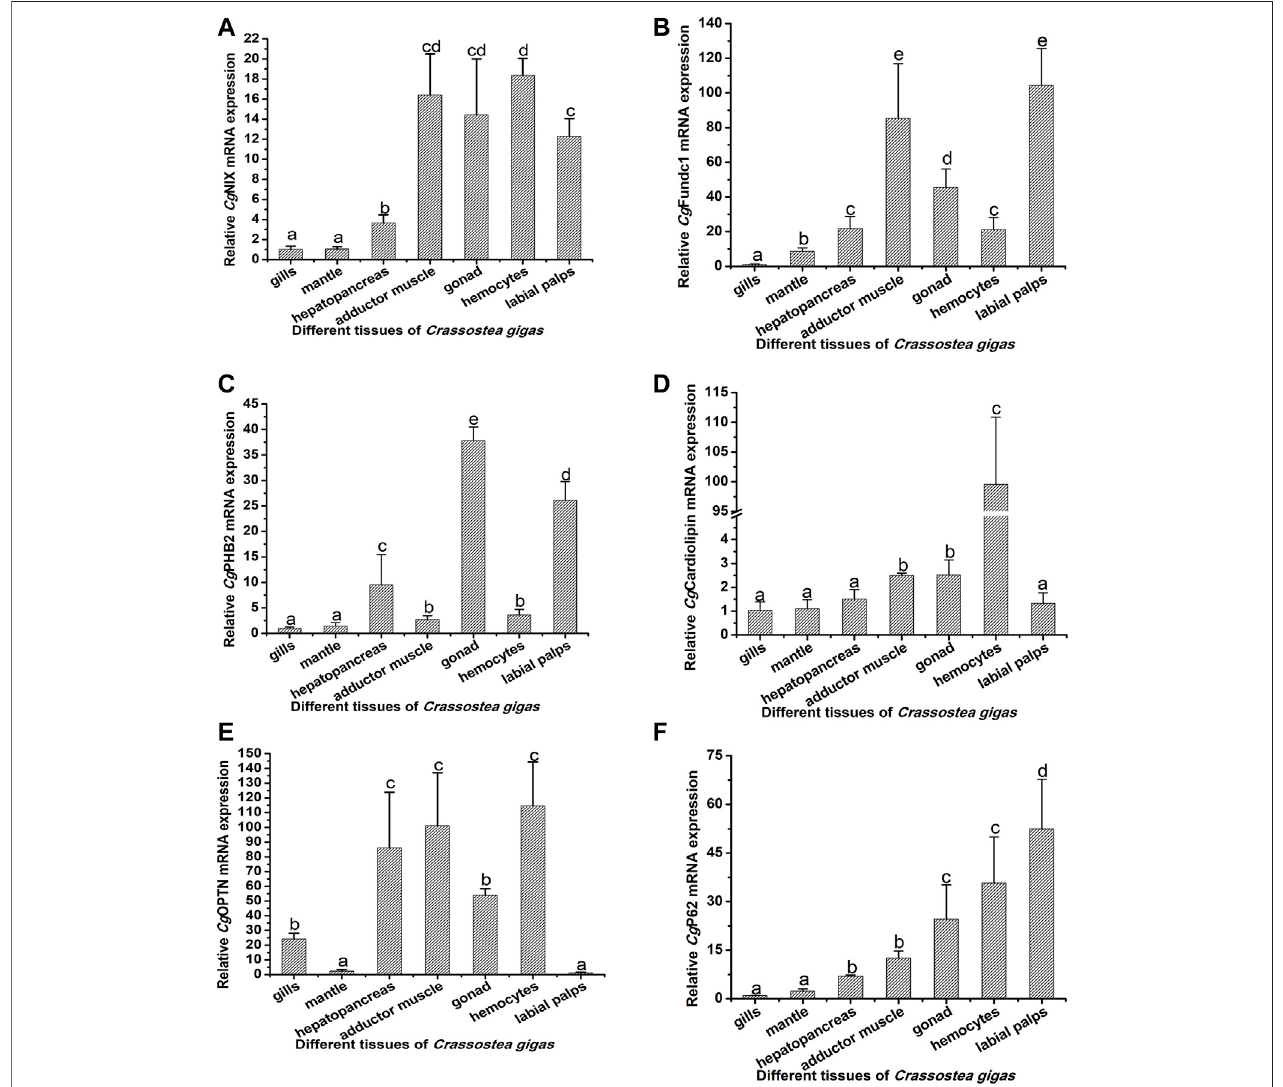
FIGURE 3| Tissue distribution of Cg NIX, Cg FUNDC1, Cg PHB2, Cg Cardiolipin, Cg P62, and Cg OPTN. The Cg EF gene was used asan internal control to calibrate thecDNAtemplateforall thesamples.TherelativemRNAexpression levelsof Cg NIX (A) , Cg FUNDC1 (B) , Cg PHB2 (C) , Cg Cardiolipin (D) , Cg P62 (E) ,and Cg OPTN (F) in different tissues (the gills, mantle, hepatopancreas, adductor muscle, gonad, hemocytes, and labial palps) were normalized to that ofgills. EF was used asthe internal control. Vertical bars show as mean ± S.D. (N = 3). The groups that do not share the same letter are signi fi cantly different from each other ( p < 0.05, one-way ANOVA), while the same letters indicate no signi fi cant differences among groups ( p > 0.05).